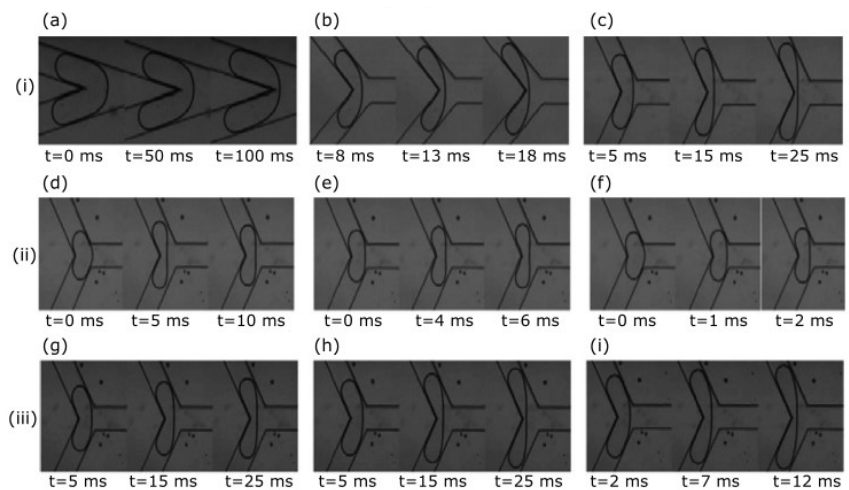
Figure 5. (i) E ff ect of the channel angle on bubble breakup: ( a ) 30 ◦ ; ( b ) 90 ◦ ; ( c ) 150 ◦ ; (ii) E ff ect of the Figure 5. ( i) Effect of the channel angle on bubble breakup: ( a ) 30°; ( b ) 90°; ( c ) 150°; (ii) Effect of the Capillary number, Ca, on bubble breakup: ( d ) Ca = 0.021; ( e ) Ca = 0.025; ( f ) Ca = 0.029; (iii) E ff ect Capillary number, Ca , on bubble breakup: ( d ) Ca (cid:3404) 0.021 ; ( e) Ca (cid:3404) 0.025 ; ( f ) Ca (cid:3404) 0.029 ; (iii) Effect of the bubble length, L , on bubble breakup: ( g ) L = 1.03 mm; ( h ) L = 1.24 mm; and, ( i ) L = 1.42 mm. of the bubble length, 𝐿 , on bubble breakup: ( g ) 𝐿 (cid:3404) 1.03 mm; ( h ) 𝐿 (cid:3404) 1.24 mm; and, ( i ) 𝐿 (cid:3404) 1.42 Adapted with permission from mm. Adapted with permission from [75].